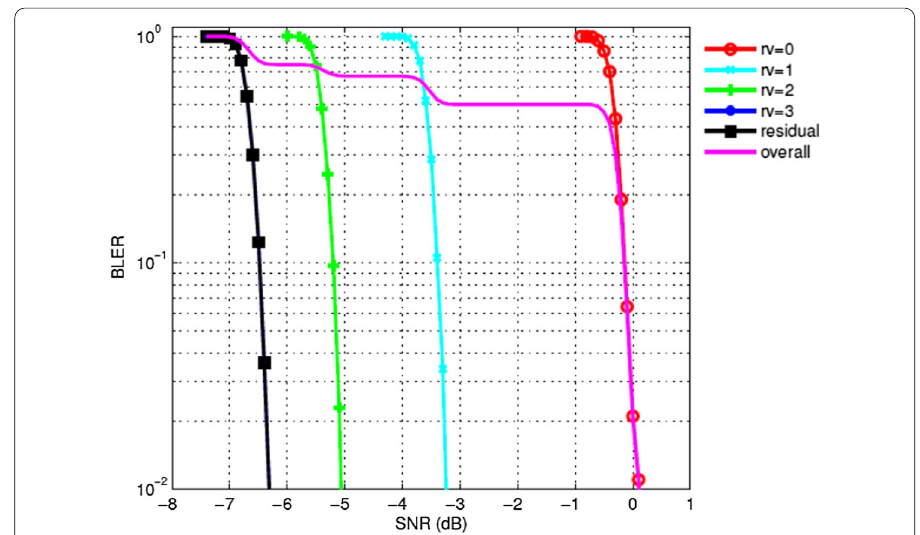
Fig. 7 BLER versus SNR for MCS index 6, AWGN channel, 25 RBs HARQ rv